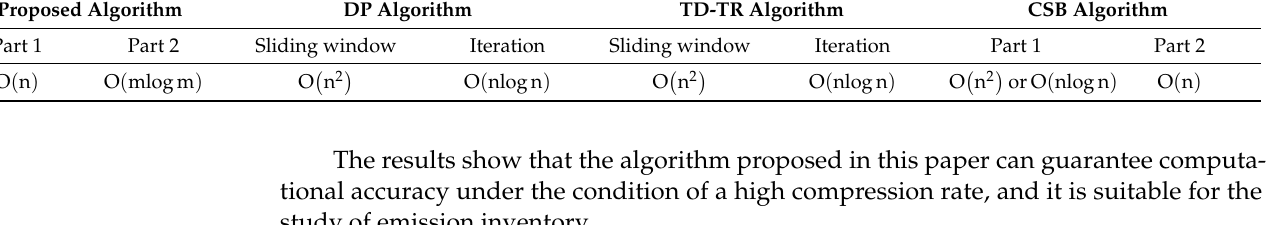
Table 4. Running time complexity of each compression algorithm. The time complexity is a function that evaluates the time consumed to execute the program and allows for the estimation of program processor use. The time complexity is often expressed in large O symbolic expressions, excluding the lower order terms and first coefficients of this function. The time complexity is evaluated when the amount of input data tends to infinity. The running time complexity of the proposed algorithm is not optimal among all algorithms, but the data classification reduces the amount of data processed per iteration. Therefore, the overall efficiency is still high. Proposed Algorithm DP Algorithm TD-TR Algorithm CSB